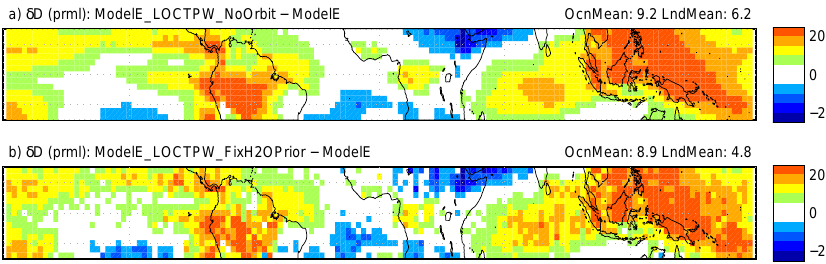
Fig. 16. Same as Fig. 15, but for two LOCTPW sensitivity tests: (a) full daytime sampling and not just along the orbital path (b) a fixed H 2 O